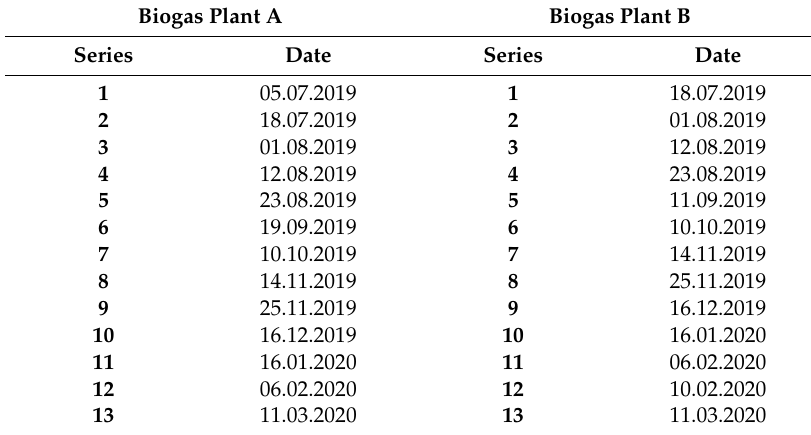
Table 2. Dates of measurement series at two biogas